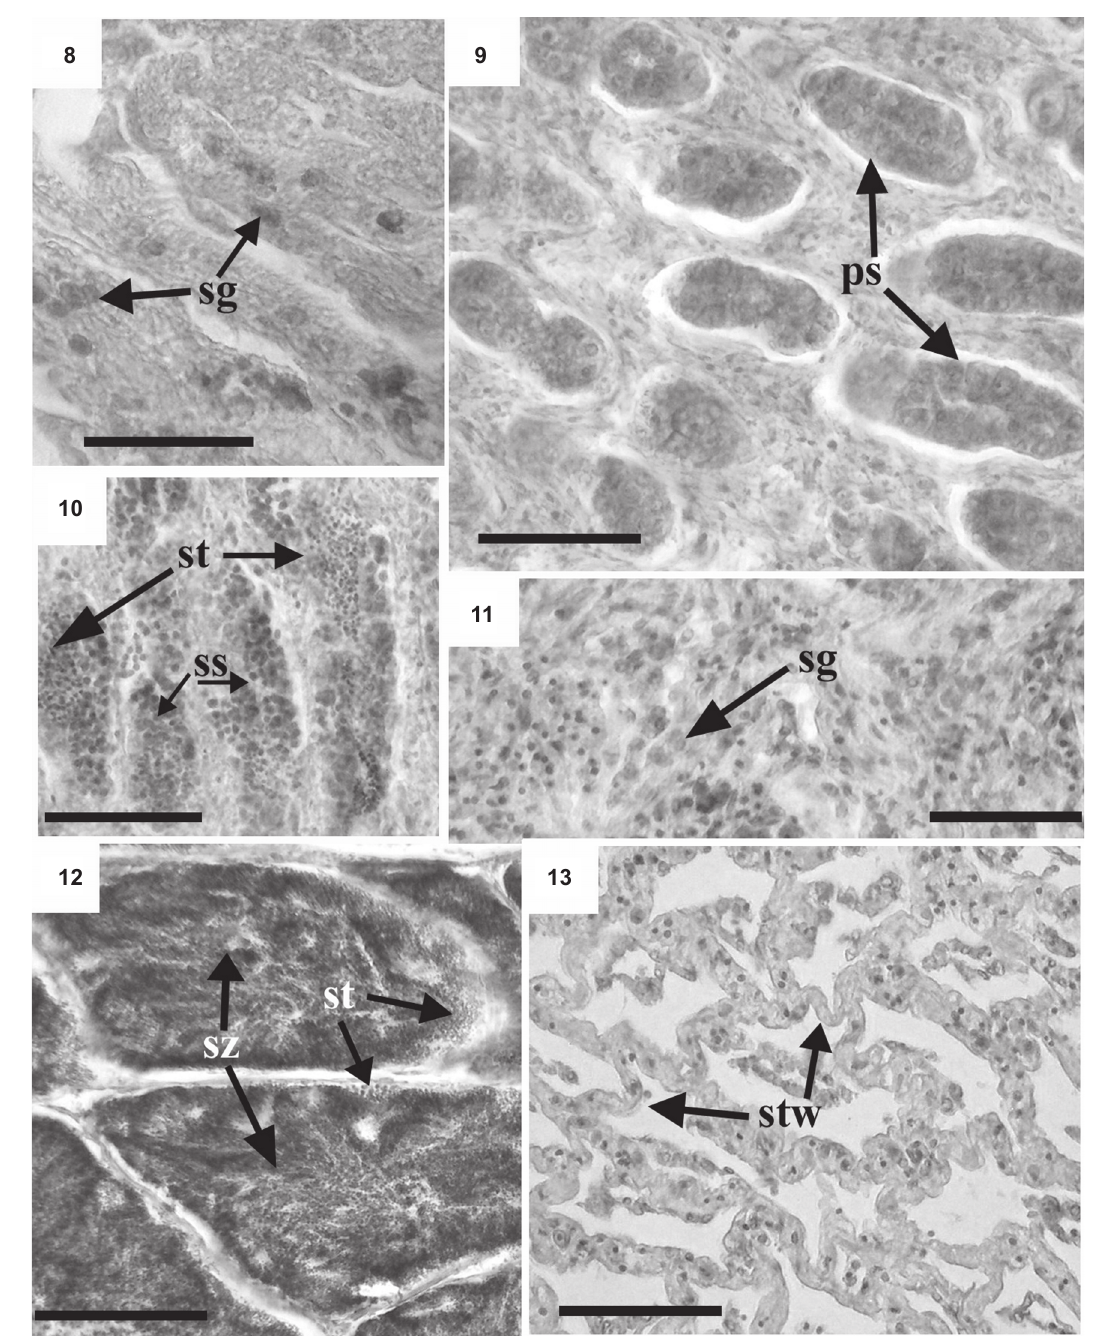
Figures 8-13. Histological sections of testes at different maturity stages of M. liza from Sepetiba Bay: (8) immature testis containing spermatogonia; (9) arrangement of primary spermatocytes forming cysts (maturation stage); (10) arrangement of different testicular cells (maturation stage); (11) maturation stage after recovering stage; (12) spreading pattern of spermatozoa in a ripe/running ripe testis (spermatids are also present in small quantities); (13) recovering testis with seminiferous tubules empty and looser. (sg) Sper- matogonia, (ps) primary spermatocytes, (ss) secondary spermatocytes, (st) spermatids, (sz) spermatozoa, (stw) seminiferous tubules wall. Scale bars: 25